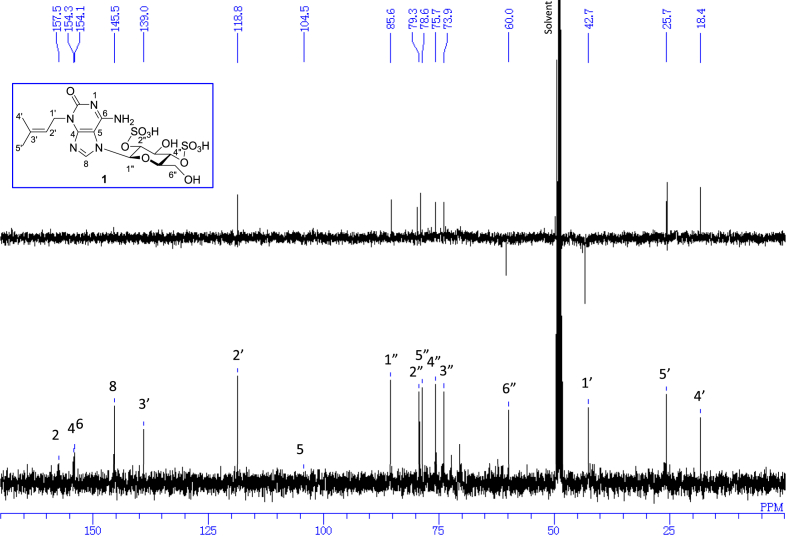
13C NMR and DEPT (100 MHz, CD3OD–D2O, 1:9) of 1.